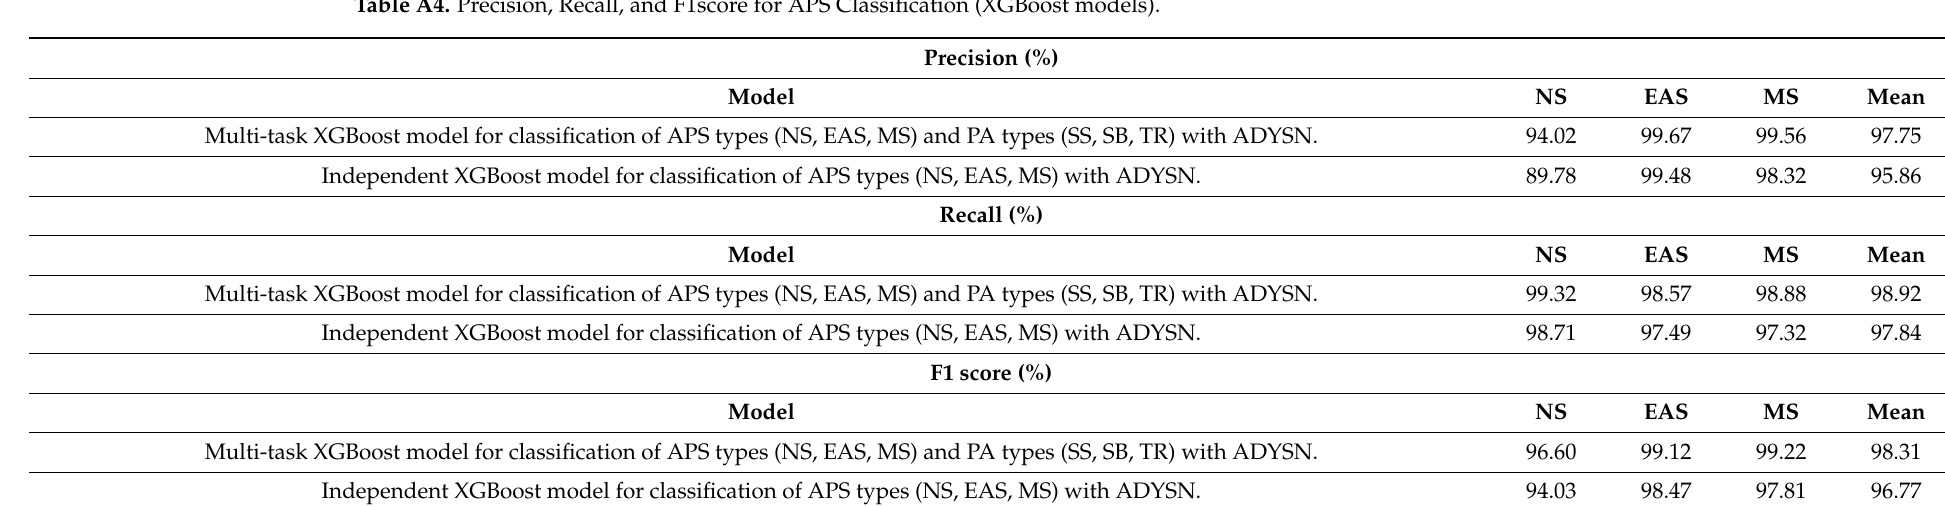
Table A4. Precision, Recall, and F1score for APS Classification (XGBoost